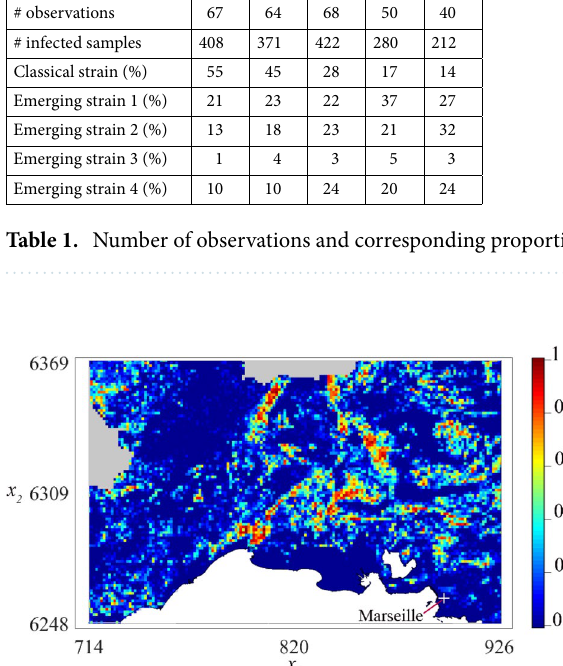
1 to the maximum density. The =